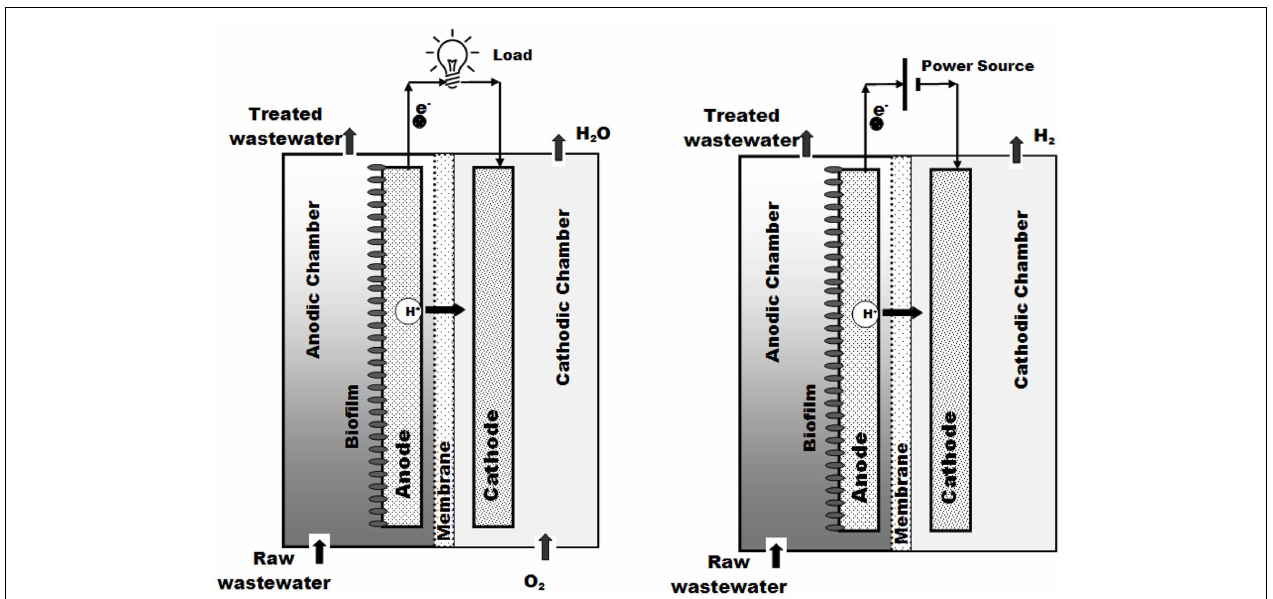
FIGURE 1 | Schematic representation of electricity production (left) and hydrogen production (right) through MFC and MEC, respectively